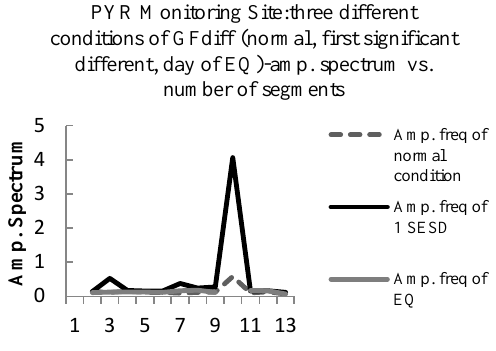
Fig. 10. Graphic of PYR monitoring site for three different condi- Fig.10. Graphic of PYR Monitoring site three different conditions of GFdiff. tions of GFdiff.